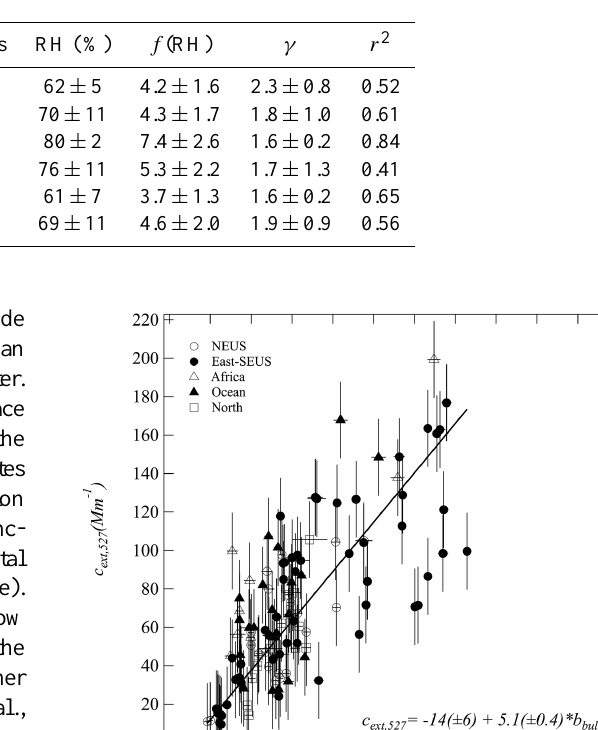
Table 1. Averages resulting from the comparison of MPL extinction and surface nephelometer extinction broken into flow regimes, with standard deviation ( σ ).